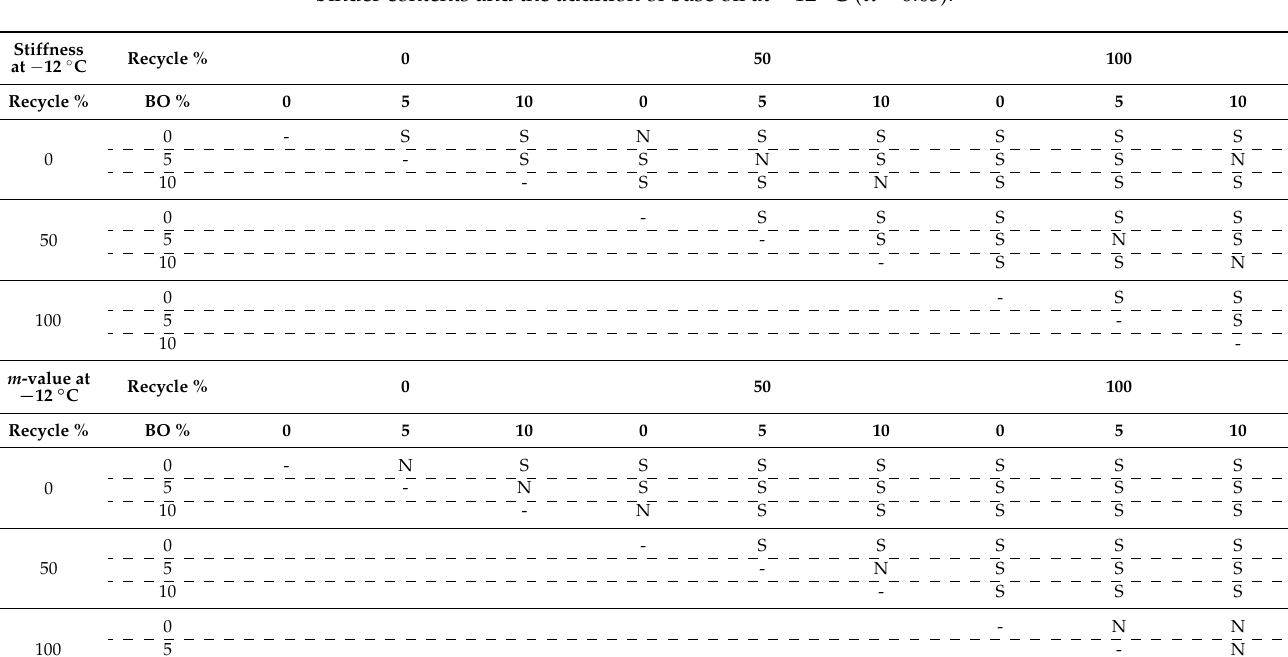
Table 7. Statistical analysis results of the stiffness and m- value for RTFO + PAV as a function of aged binder contents and the addition of base oil at − 12 ◦ C ( α =